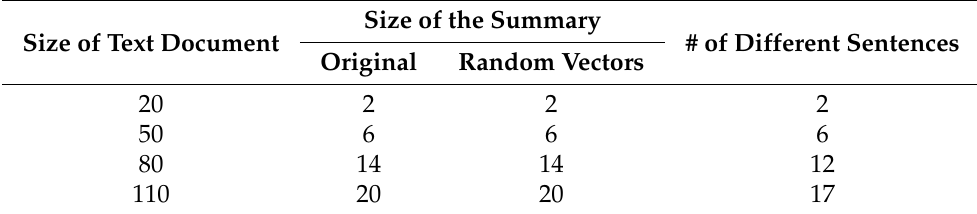
Table 8. Text summarization results of random vectors.